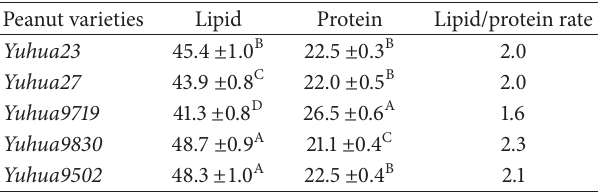
Table 1: Composition (g/100g dry matter) of five peanut